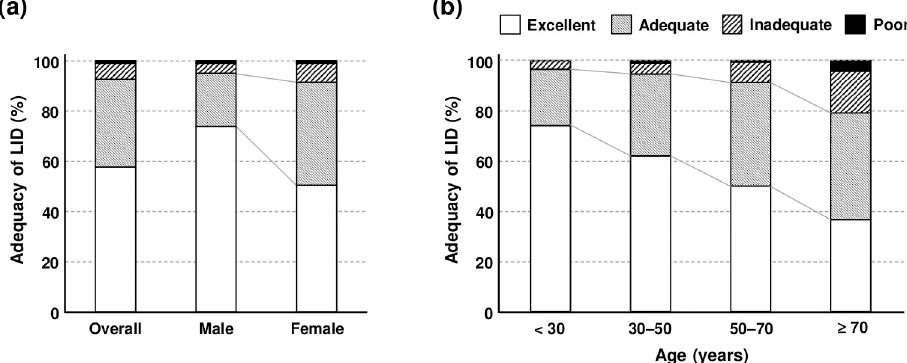
Fig 2. Adequacy of LID according to sex (a) and age (b). Male and young patients showed higher proportion of ‘excellent’ adequacy.